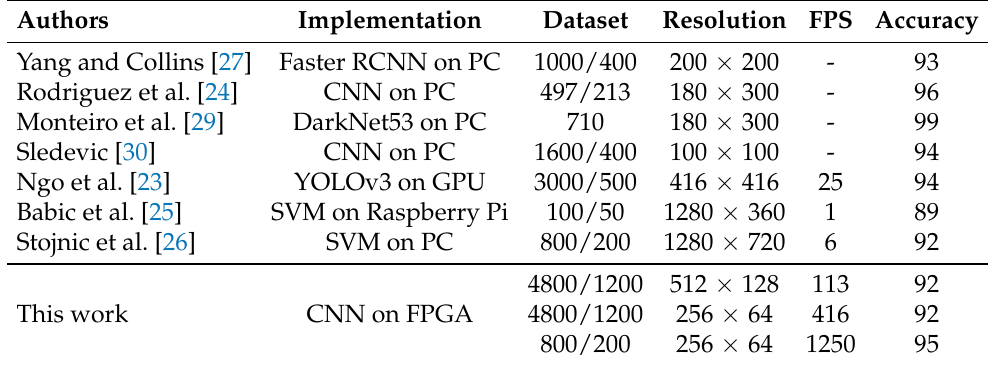
Table 4. Comparative evaluation of the proposed implementation with state-of-the-art